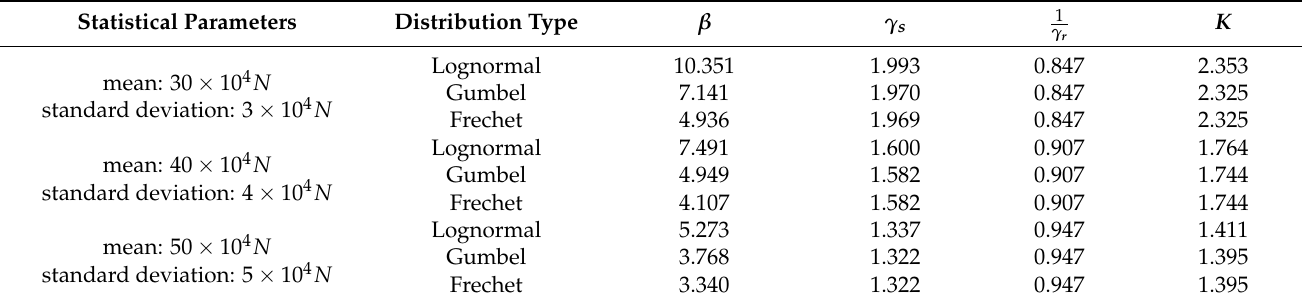
Table 3. Coefficients and local safety factors under different load distributions and